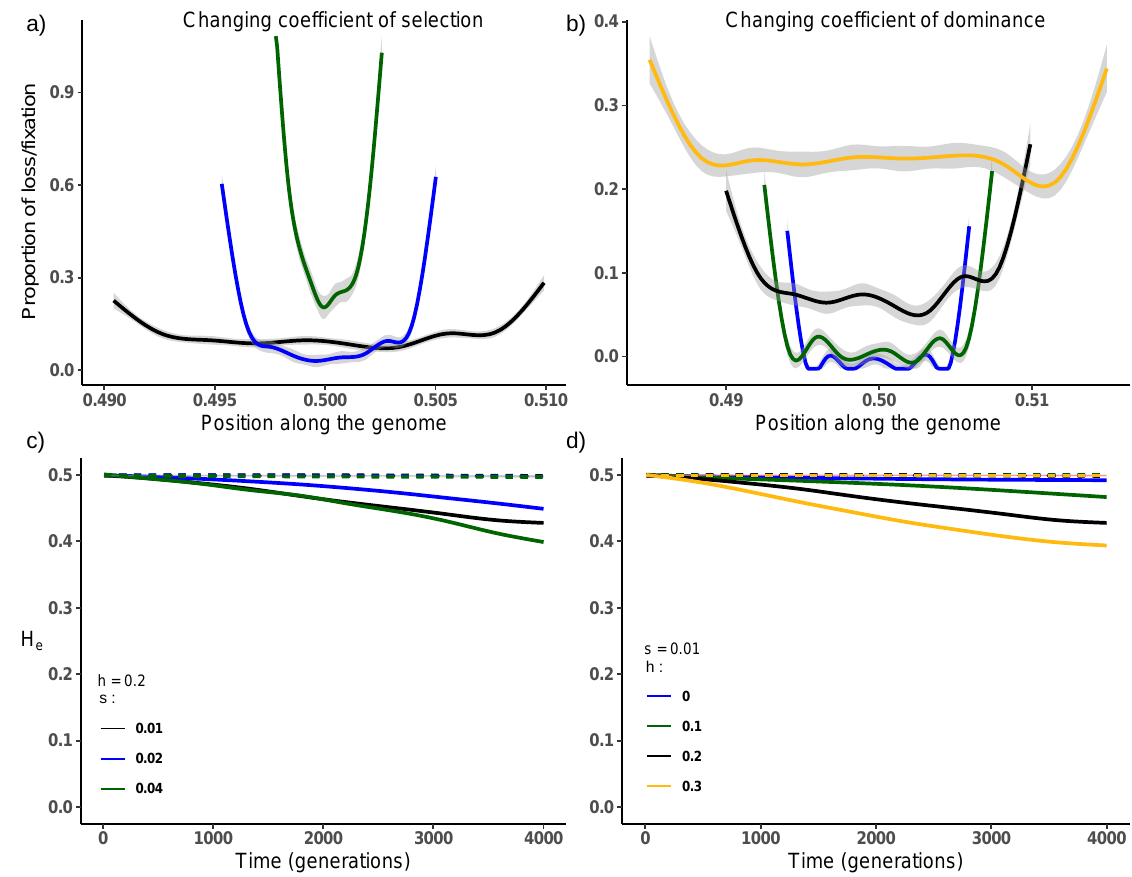
Figure S3 – Effects of levels of selection and dominance on selection dynamics within a POD zone (compare to Fig. 2). Left panels show the effects of varying coefficients of selection at each load locus ( s = 0.01, 0.02 and 0.04 , corresponding to n L = 100, 50 and 25 loci). Dominance is fixed at h = 0.2 and s H = 0.45 . Right panels show the effects of varying dominance ( h = 0, 0.1, 0.2 and 0.5 with n L = 60, 75, 100 and 150 ) with selection fixed at s = 0.01 . Panels a) and b) show observed frequencies of fixation/loss along the POD zone (x values represent the position of the loci along the chromosome). The 4 M selfing rate σ = 0 and linkage ℓ = 10 − . Panels c) and d) show losses in heterozygosity ( H e ) over time in populations with a high selfing rate ( σ = 0.95 ) and either loose linkage 4 M 5 M ( ℓ = 10 − , solid lines) or tight linkage ( ℓ = 10 − , dashed